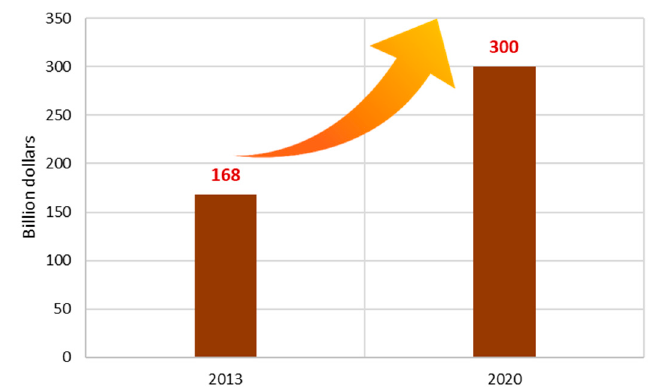
Figure 5. Global market value of functional foods [109,110] .